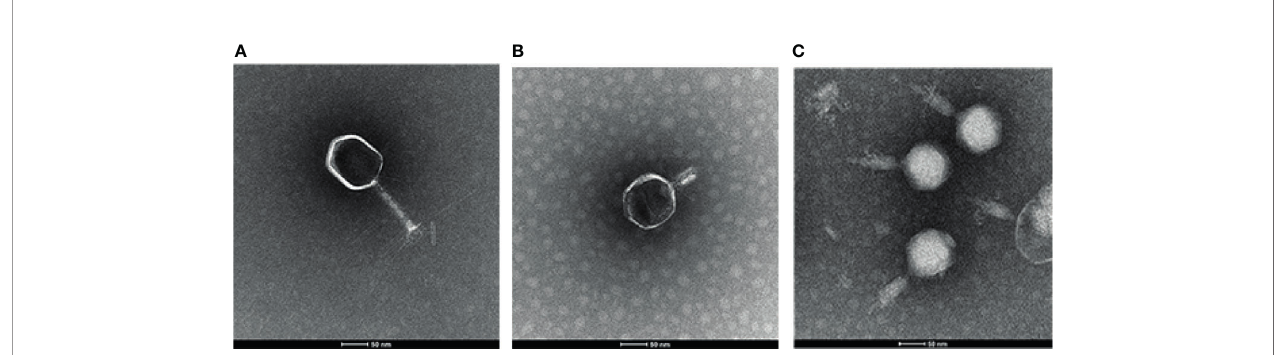
FIGURE 1 | Images of phage particles by transmission electron microscopy. (A) vB_EcoM_SYGD1. (B) vB_EcoP_SYGE1. (C) vB_EcoM_SYGMH1 (scale bar was